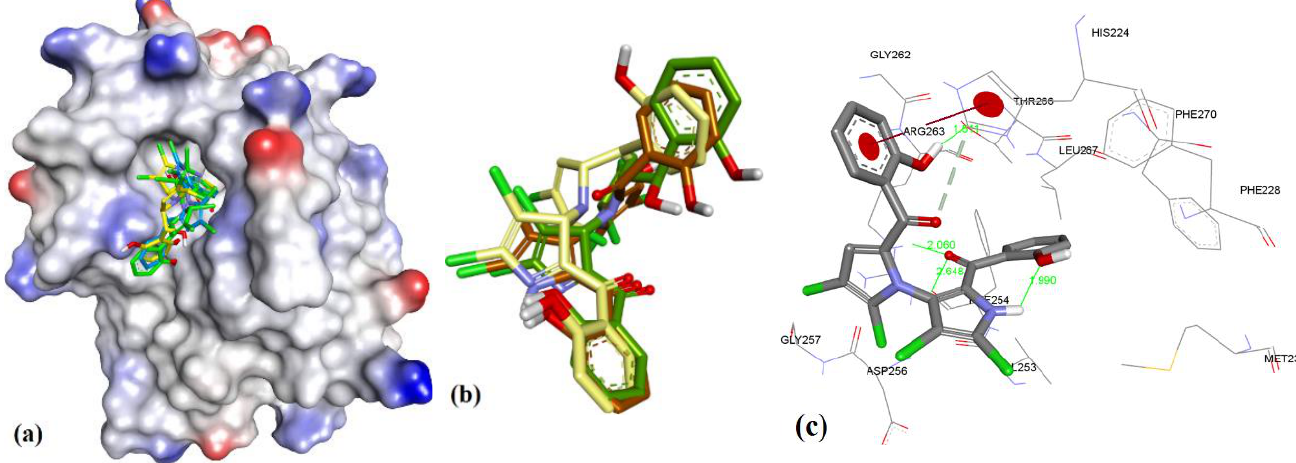
Figure 17. ( a ) The ionized solvent-exposed surface mapping of hMcl-1 along with the docked poses of marinopyrrole from MOE (in blue), AutoDock (in green), and VlifeDock (in yellow) show their fitting to the cavity. ( b ) Similar-pose ensemble clustering of all three poses was attained from the three different docking methods, MOE (in brown), AutoDock (in green), and VlifeDock (in yellow). ( c ) Binding mode of marinopyrrole.